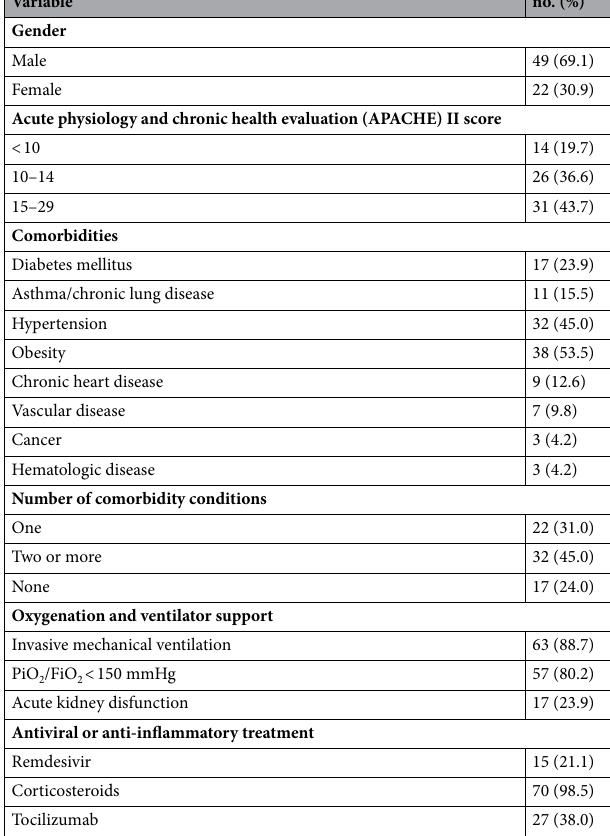
Table 1. Clinical characteristics of the study population at Intensive Care Unit